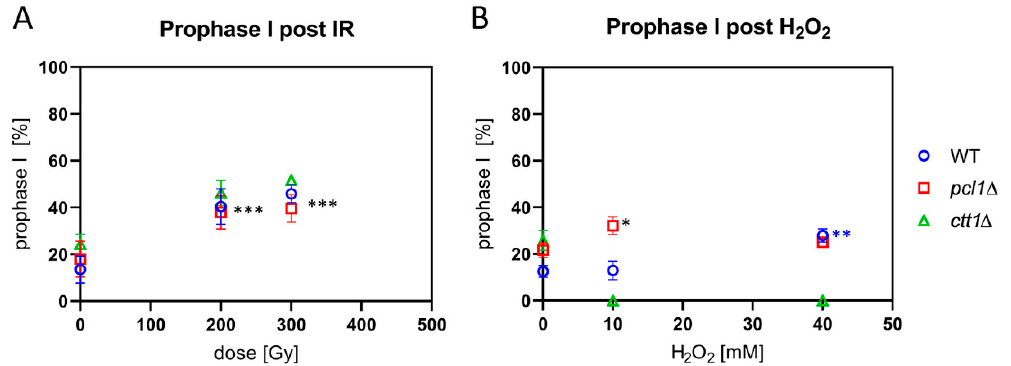
Figure 6. Prophase I progression after IR and H 2 O 2 exposure. ( A ) IR significantly increased the average percentage of horsetail cells in prophase I in wild-type (WT), pcl1 ∆ , and ctt1 ∆ strains at both doses used ( *** p ≤ 0.0005), relative to control. ( B ) H 2 O 2 treatment killed ctt1 ∆ meiocytes, but significantly (* p = 0.013) increased the average percentage of pcl1 ∆ horsetail prophase I cells relative to control and 10 mM-treated WT cells. 40 mM H 2 O 2 led to a significant increase of horsetail cells only in the WT ( ** p = 0.0006), indicating delayed progression through WT prophase I. Data points reflect the mean of three experiments (±SD).